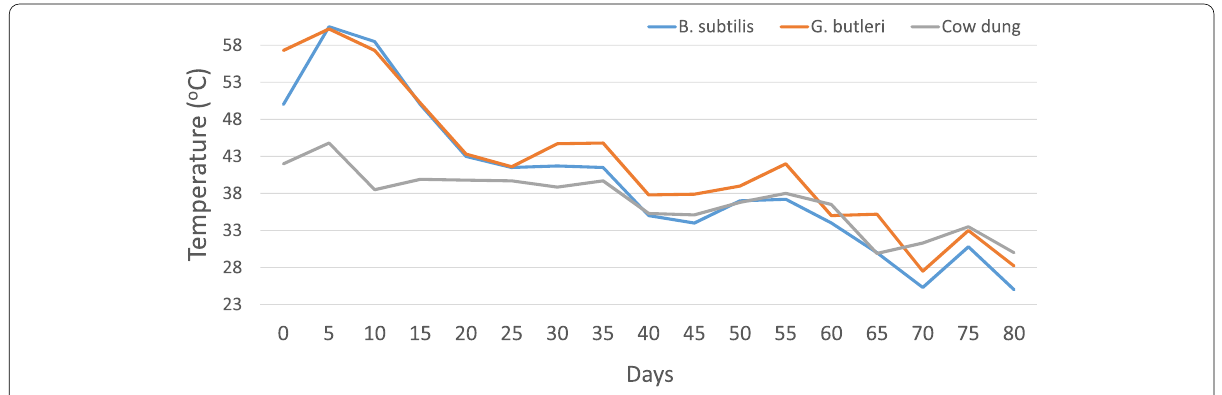
Fig. 3 Variation in temperature among different composting treatments during the first 80 days